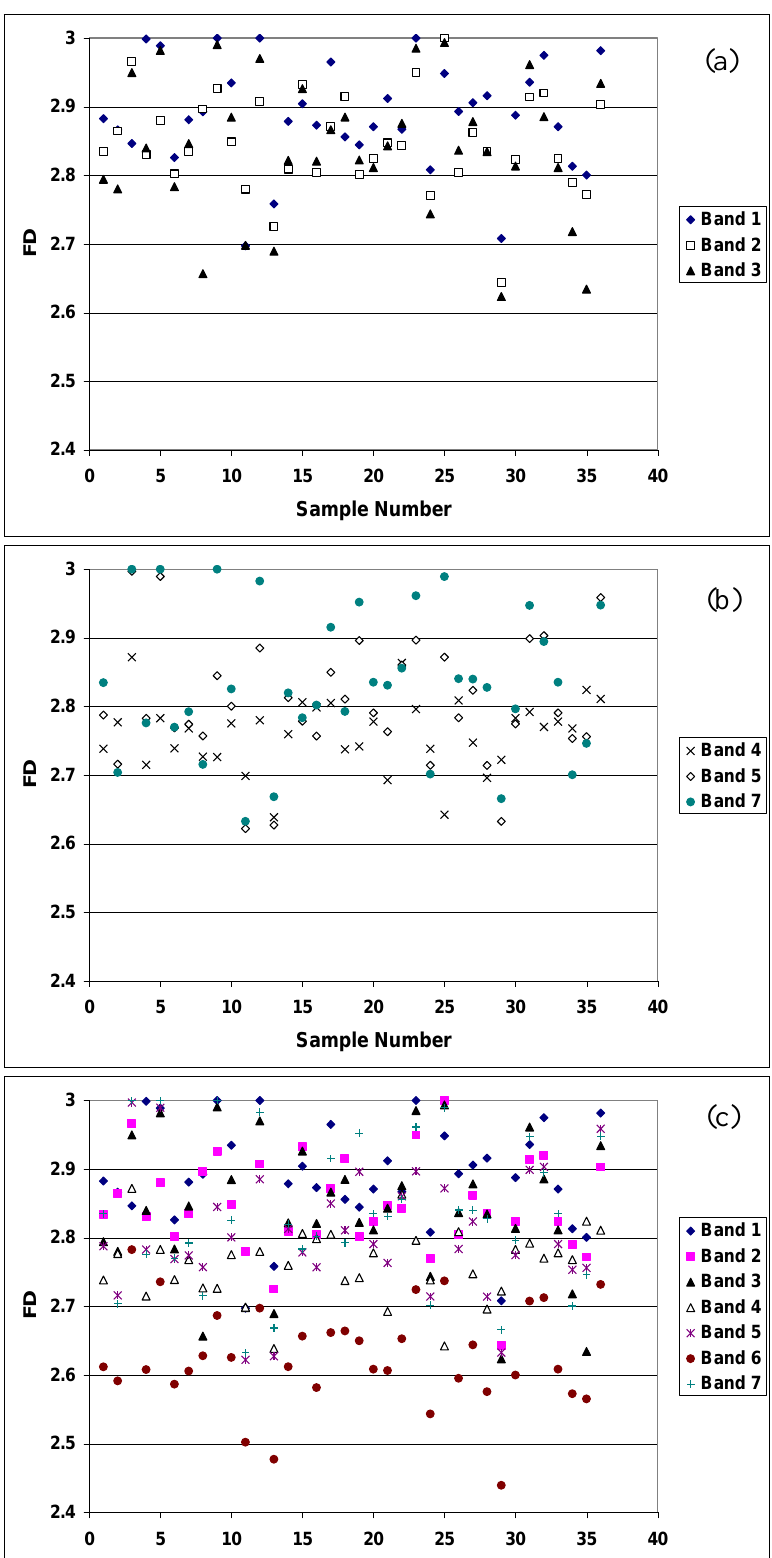
Figure 12. Fractal dimension values of samples within Talladega National Forest: (a) visible bands (b) near and middle infra red bands (c) all